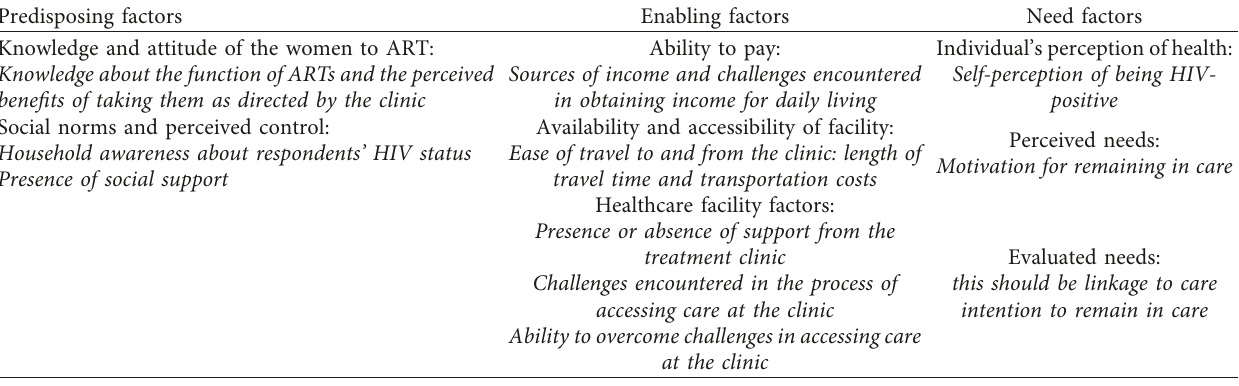
Table 1: Summary of themes and sub-themes using Andersen and Newman’s behavioral model of healthcare utilization. Predisposing factors